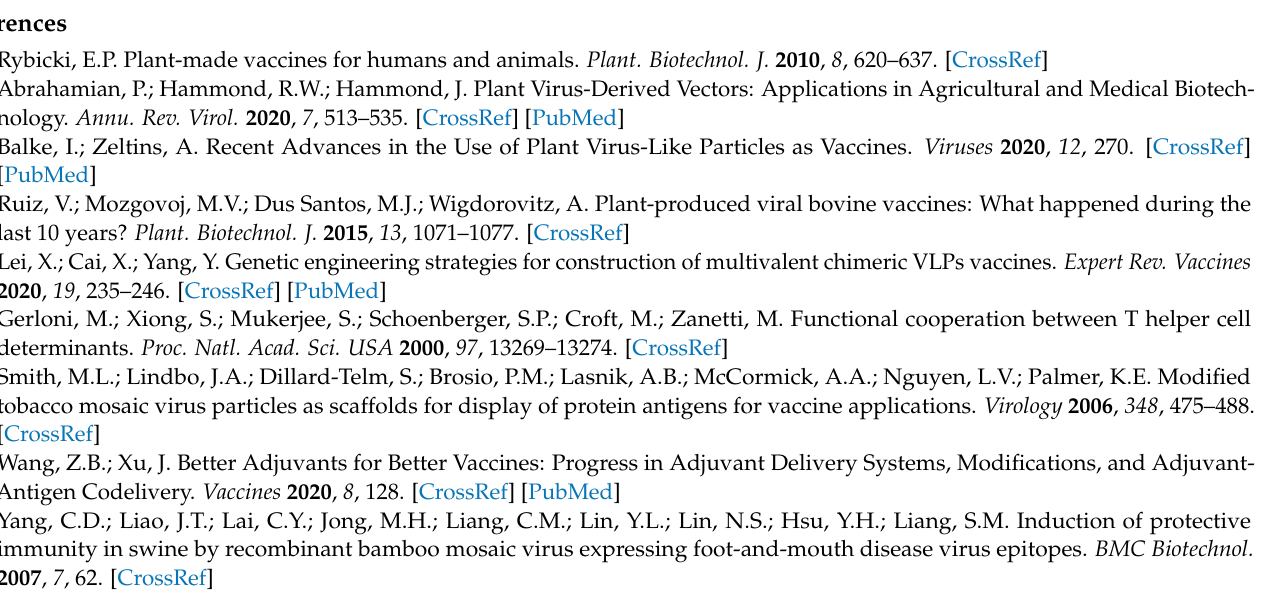
Figure S1. Comparison of the nucleotide and amino acid sequences of the PVX coat protein (CP) (GenBank ID: AAA03493.1) and PVX Taiwan strain (PVX-T) CP (GenBank ID: AF272736.2); Figure S2. Comparison of the amino acid sequences and secondary structure of the PVX Taiwan strain (PVX-T) coat protein (CP) (GenBank ID: AF272736.2) and BS-d35CP; Figure S3. Schematic representation of the recombinant pPVP1-97s and pPVP1-99s based on PVX genome; Figure S4. Symptoms and molecular analysis of plants inoculated with the potato virus X viral expression vectors; Figure S5. PVX chimeric particles produce antibodies for the distinction between FMDV O strain topotypes. Table S1. List of the nonconsensus N-terminal sequences of the chimeric BaMV CP putatively encoded by each construct. Table S2. The primers used in this